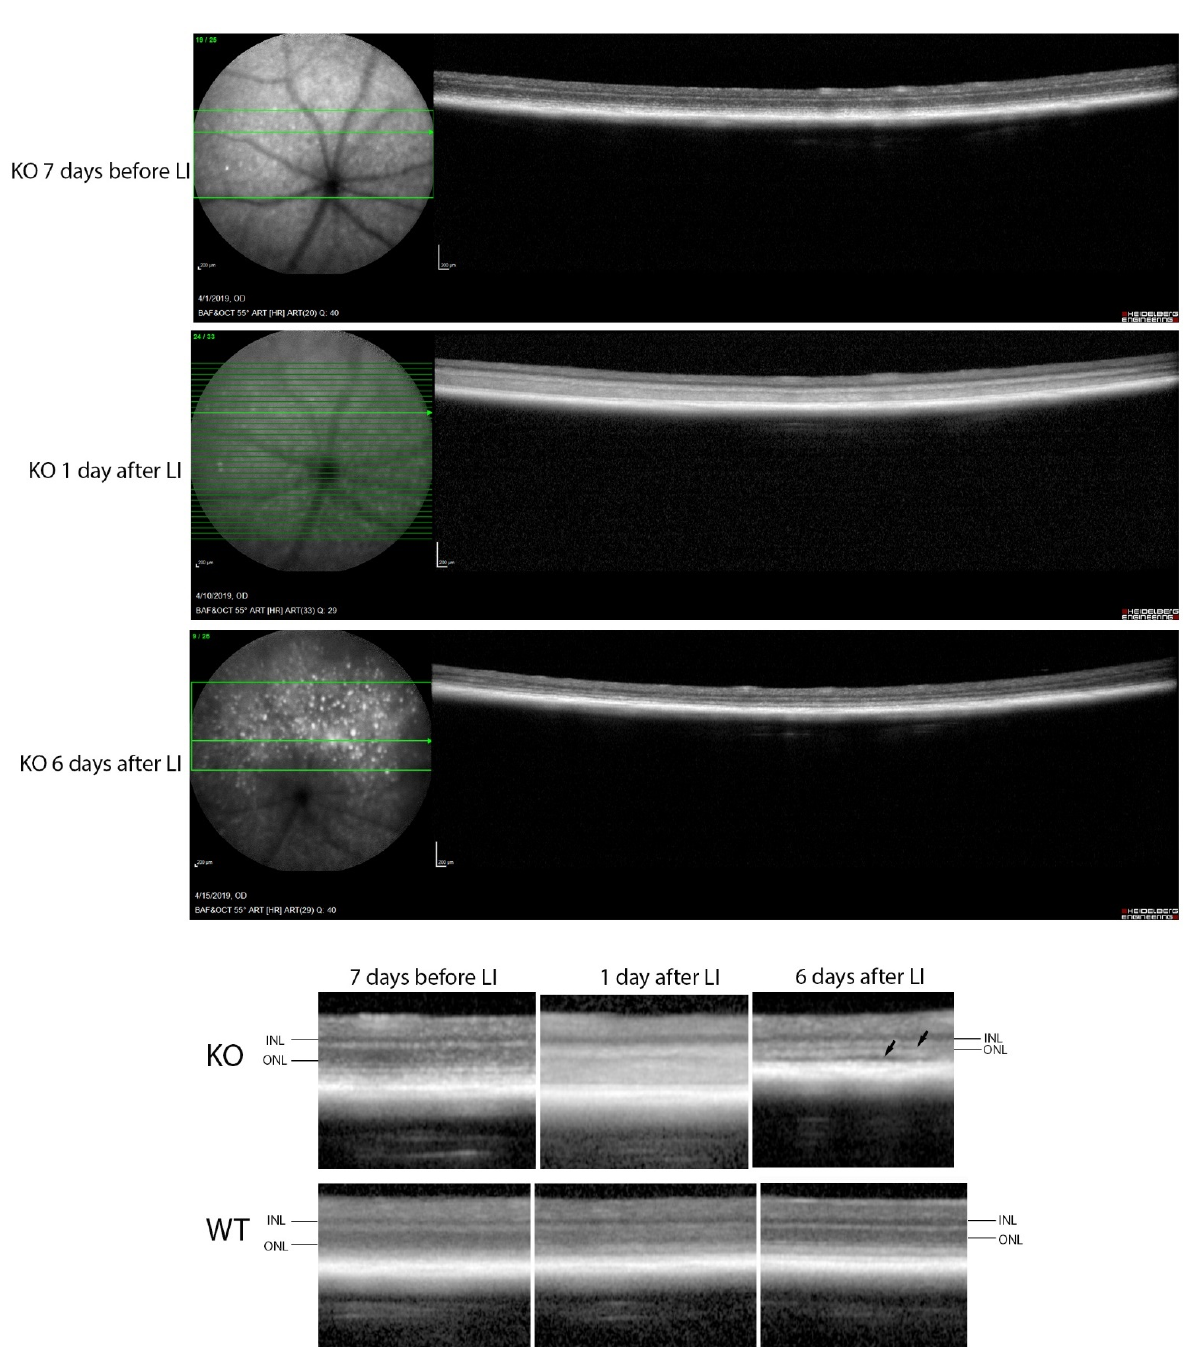
Figure 9. OCT imaging of mice before and after light stress. Top : KO mouse retina 7 days before and 1 and 6 days after light stress. Bottom : comparison of WT and KO retinas at the same time points, with arrows showing a narrowing of the ONL, and separation of the photoreceptor layer from the RPE in the KO but not the WT. Scale bar = 200µm.